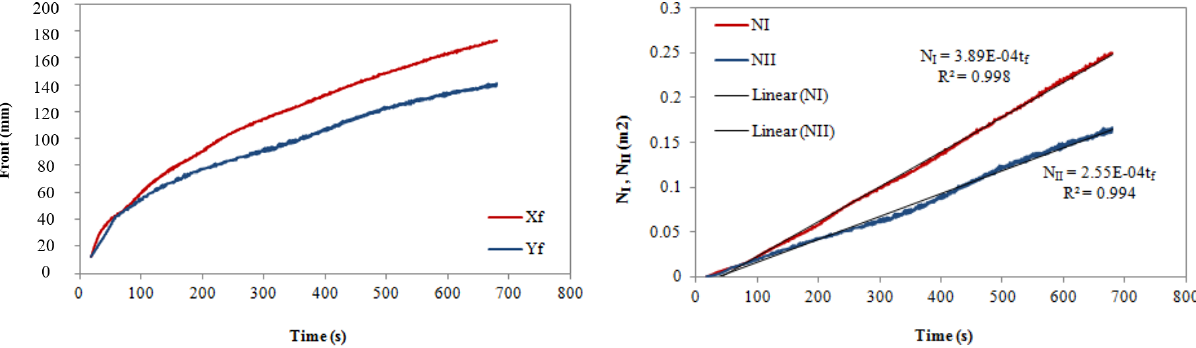
The different value of permeability in I and II direc- x-direction. The experimental data is rearranged in order to tions confirms anisotropy in the preform material. Source express the development of resin front against the elapsed of this anisotropy is the different interspacing in warp and time as shown in Figure 7. Initially, the anisotropic effect weft directions as observed in microscopic is not so clear with an overlap in the x and y until ~70 f f seconds from the start of experiment. Afterwards, the pre- form started to behave typically anisotropic until the end of experiment which lasts for 680 seconds.